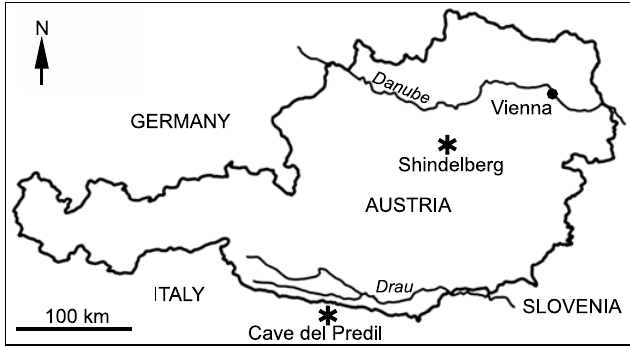
Fig. 1. Sketch map showing the position of the localities Cave del Predil, NE Italy, and Schindelberg, Lower Austria